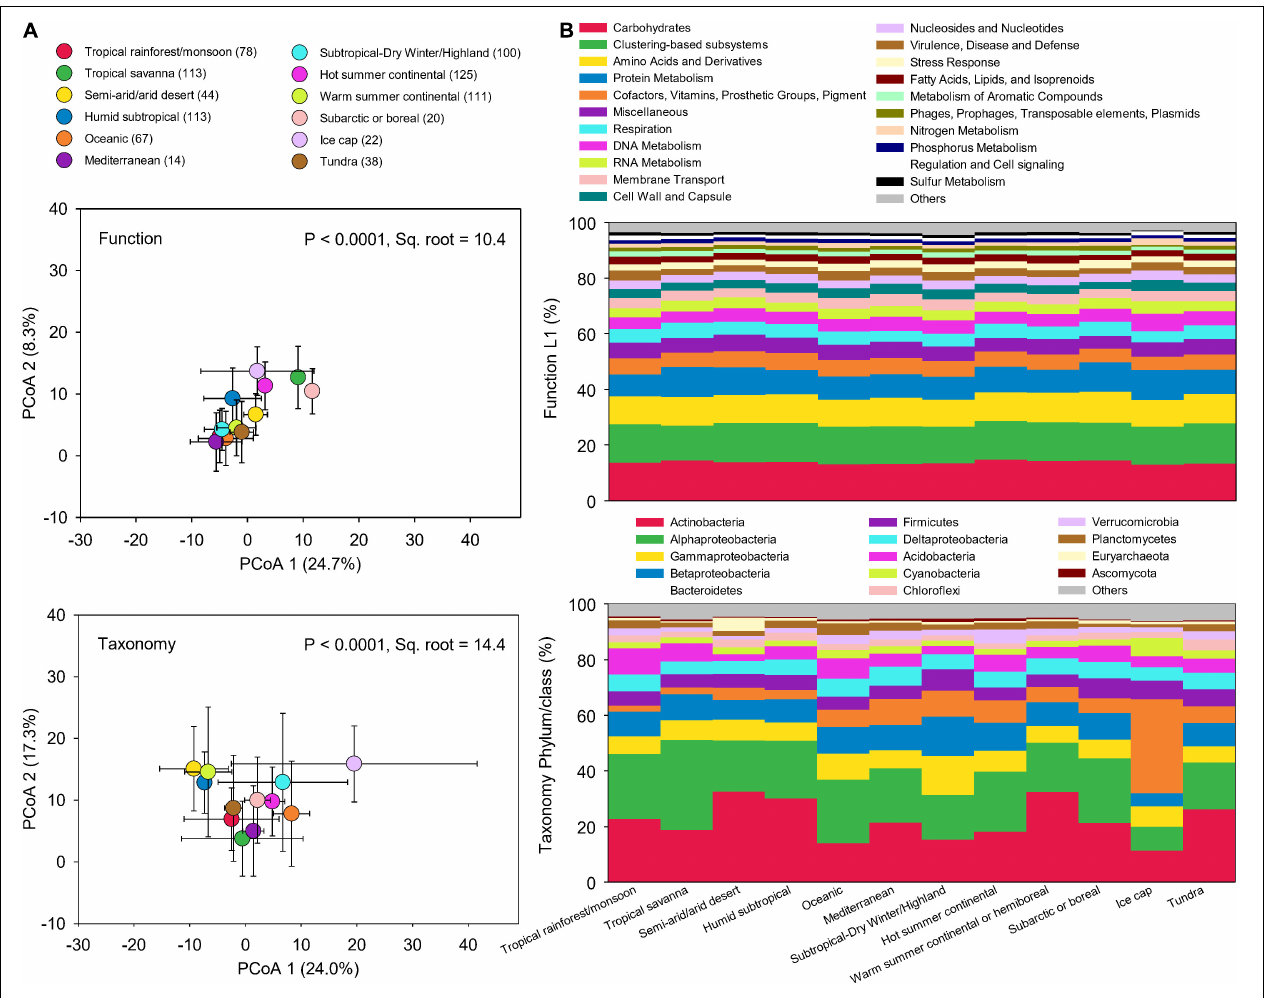
FIGURE 4 | Functional and taxonomic compositions across climate zones. (A) Principal coordinates analysis (PCoA) showing beta-diversity of soil metagenomes annotated in the SEED Subsystems database at Level 3 (Function) and RefSeq database at genus level (Taxonomy) grouped by different climate zones. The error bars represent the standard deviation of data ranges. Sample sizes of each climate zone classification are given in parentheses. Variation explained by two principal coordinate dimension is given in parentheses by percentage. P -values and Sq. root of PERMANOVA are also given. (B) Relative abundance of dominant